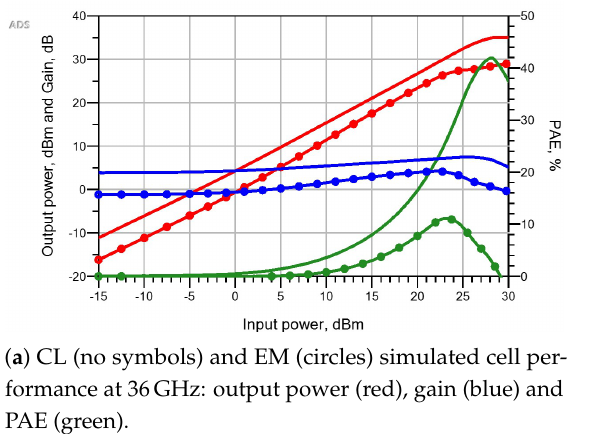
Figure 19. Comparison between CL and EM simulations for the L SHUNT cell.